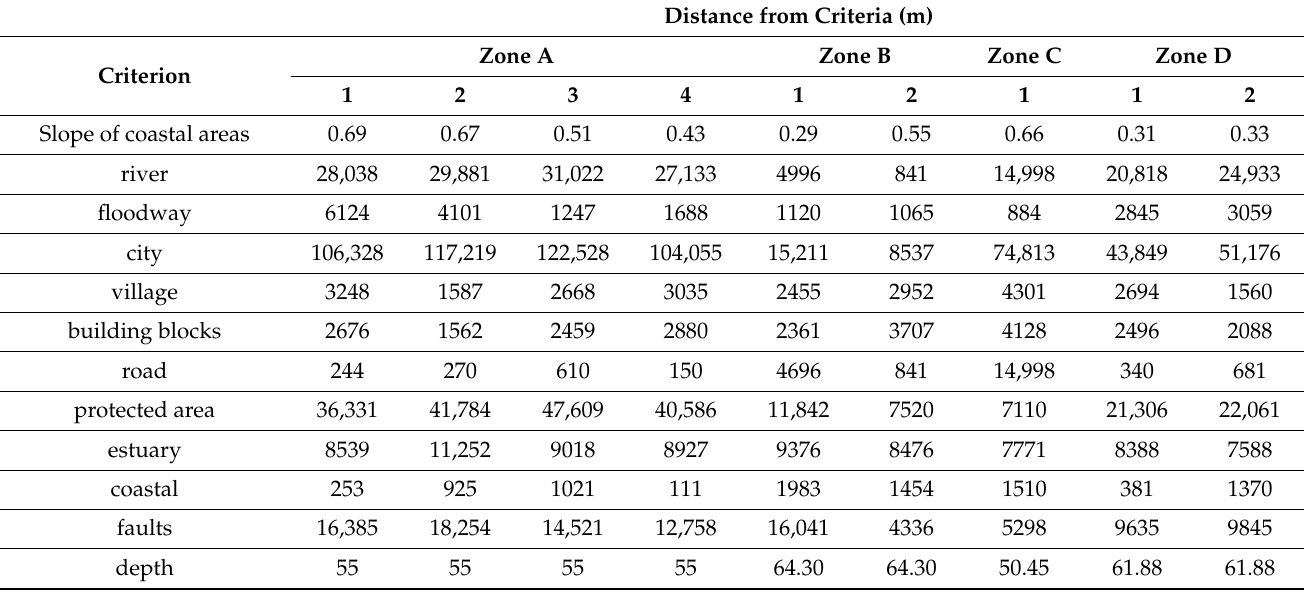
Table 4. The average suitability of the criteria in the eastern part of